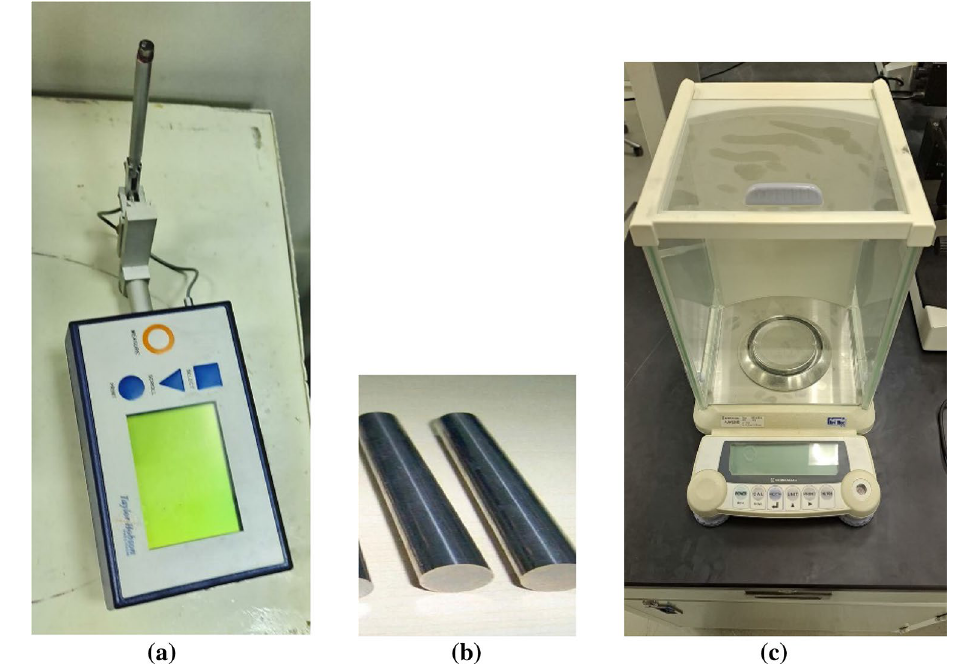
Fig. 2 a Surface roughness measurement using Surtronic 25 Taylor Hobson, b Wokpiece material, c Analytical Balance (Auw 220)